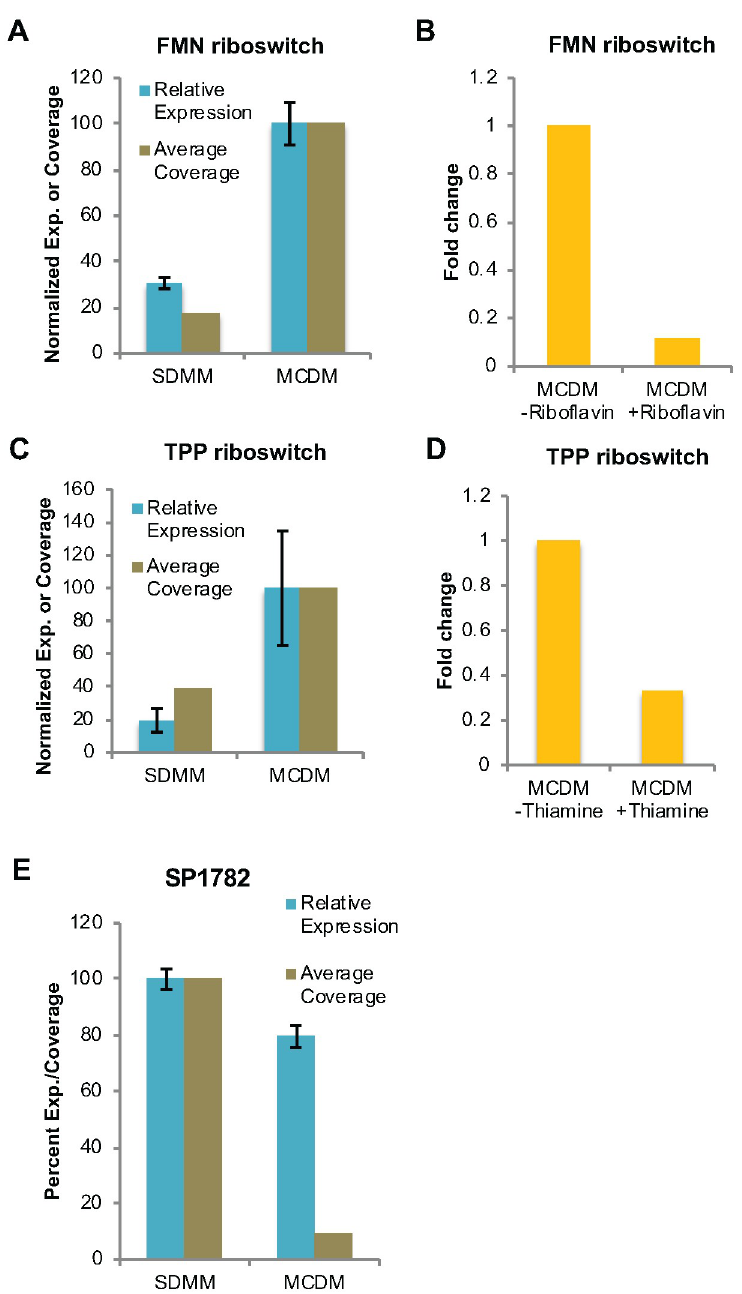
Fig 5. Validation of the regulatory activities of FMN, TPP riboswitches and a putative 5’-UTR regulatory candidate in different nutrient conditions. The relative expression and average RNA-Seq coverage of SP_0178 (FMN) (A) and SP_0716 (TPP) (C) increases in poor (MCDM) medium compared to rich (SDMM) medium, potentially compensating for the depletion of the specific ligand. Error bars represent standard error of the mean. Expression of SP_0178 (FMN) (B) and SP_0716 (TPP) (D) is reduced when the poor medium is supplemented with respective ligands thus confirming the regulatory activities of FMN and TPP riboswitches. (FMN- Riboflavin; TPP- Thiamine). Expression is relative to the qPCR internal control and thus for instance an expression level of 0.5 means that the expression of tested gene is 50% of the expression of internal control. Error bars represent standard error of the mean across three technical replicates. SP_1782 encoding ribosomal protein L11 methyltransferase (E) decreases in poor media (MCDM) compared to rich media (SDMM).